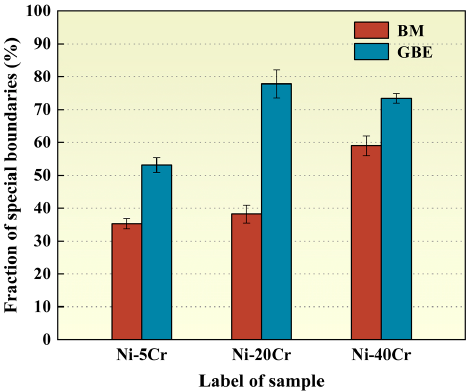
Figure 6. Comparison of special grain boundary proportions in BM and GBE samples.